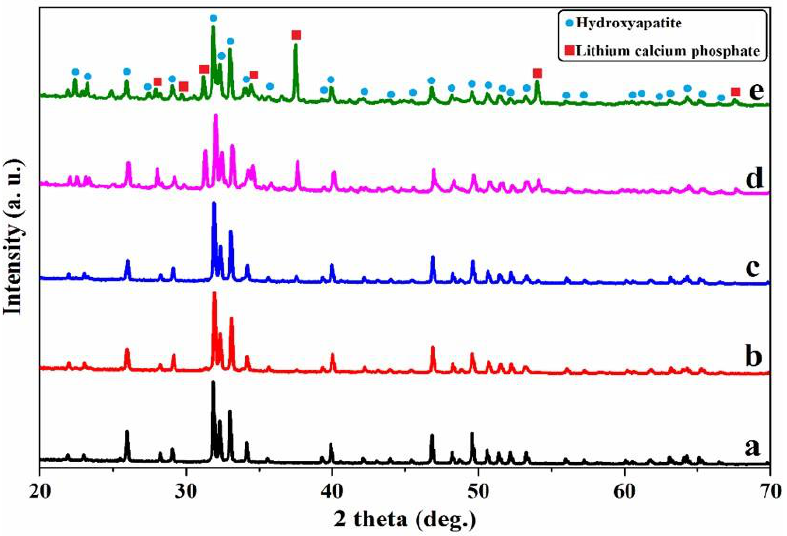
Figure 1. XRD pattern of: ( a ) HA. ( b ) HA-0.5Li. ( c ) HA-1Li. ( d ) HA-2Li. ( e ) HA-4Li sintered at 1250 °C. Table 1. Diffraction characteristics of HA and Li-doped HA